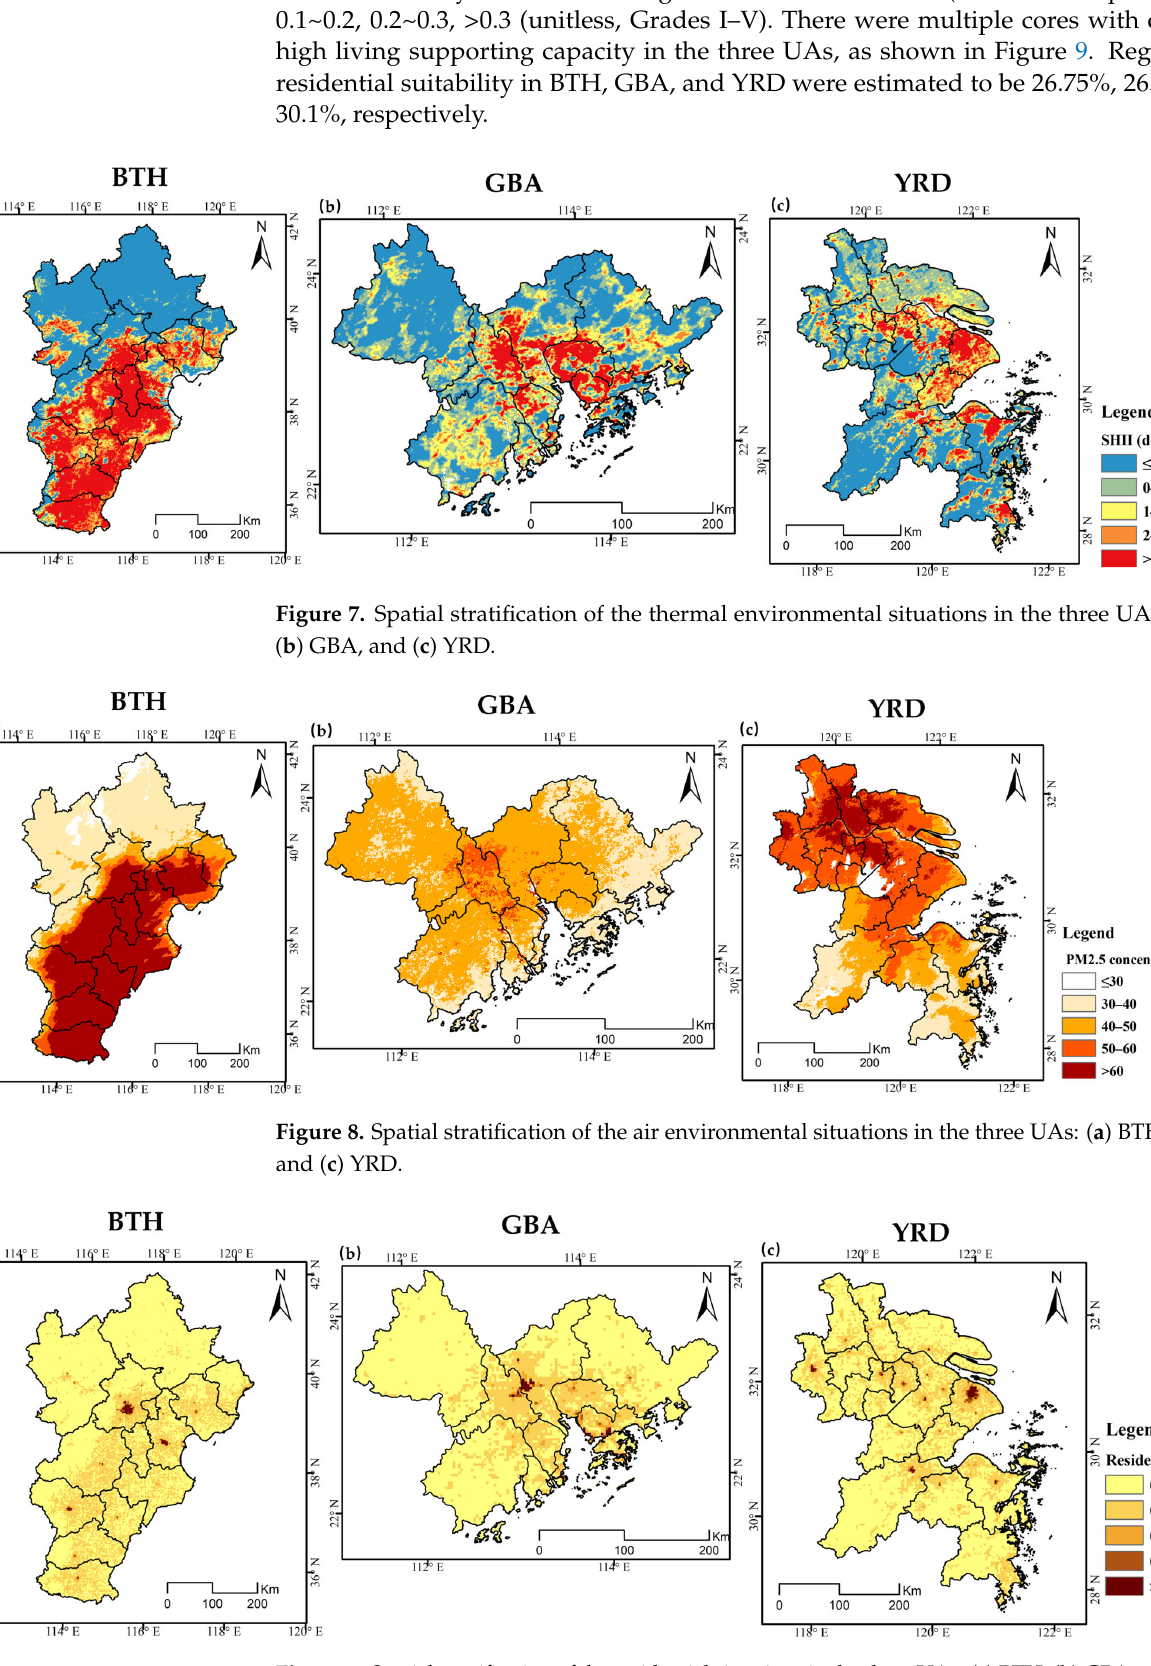
Figure 9. Spatial stratification of the residential situations in the three UAs: ( a ) BTH, ( b ) GBA, and ( c ) YRD.